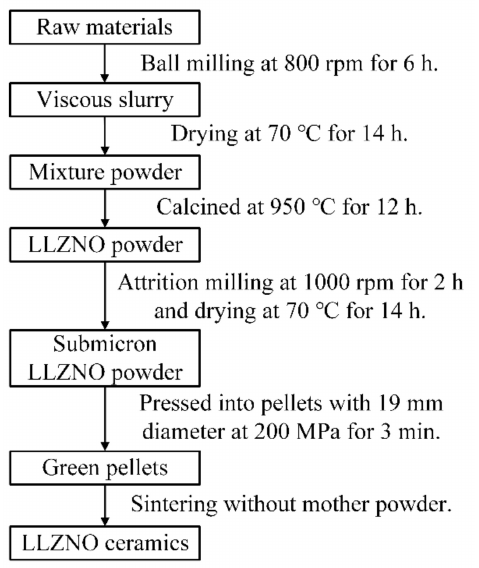
Figure 1. Process flow chart for the preparation of submicron Li 6.6 La 3 Zr 1.6 Nb 0.4 O 12 (LLZNO)